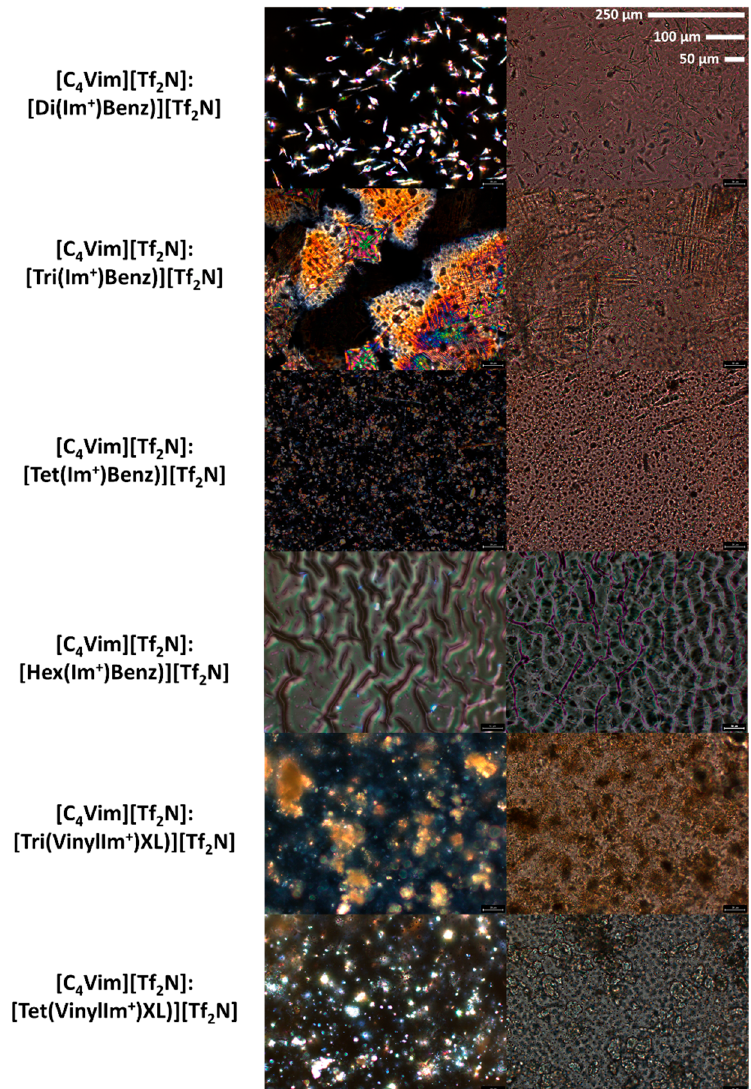
Figure 6. Polarized light microscopy (PLM) images of each thin film, at 20× magnification (reference enlarged scale bars), utilizing the polarized filter (left, 180°; right, 0°).